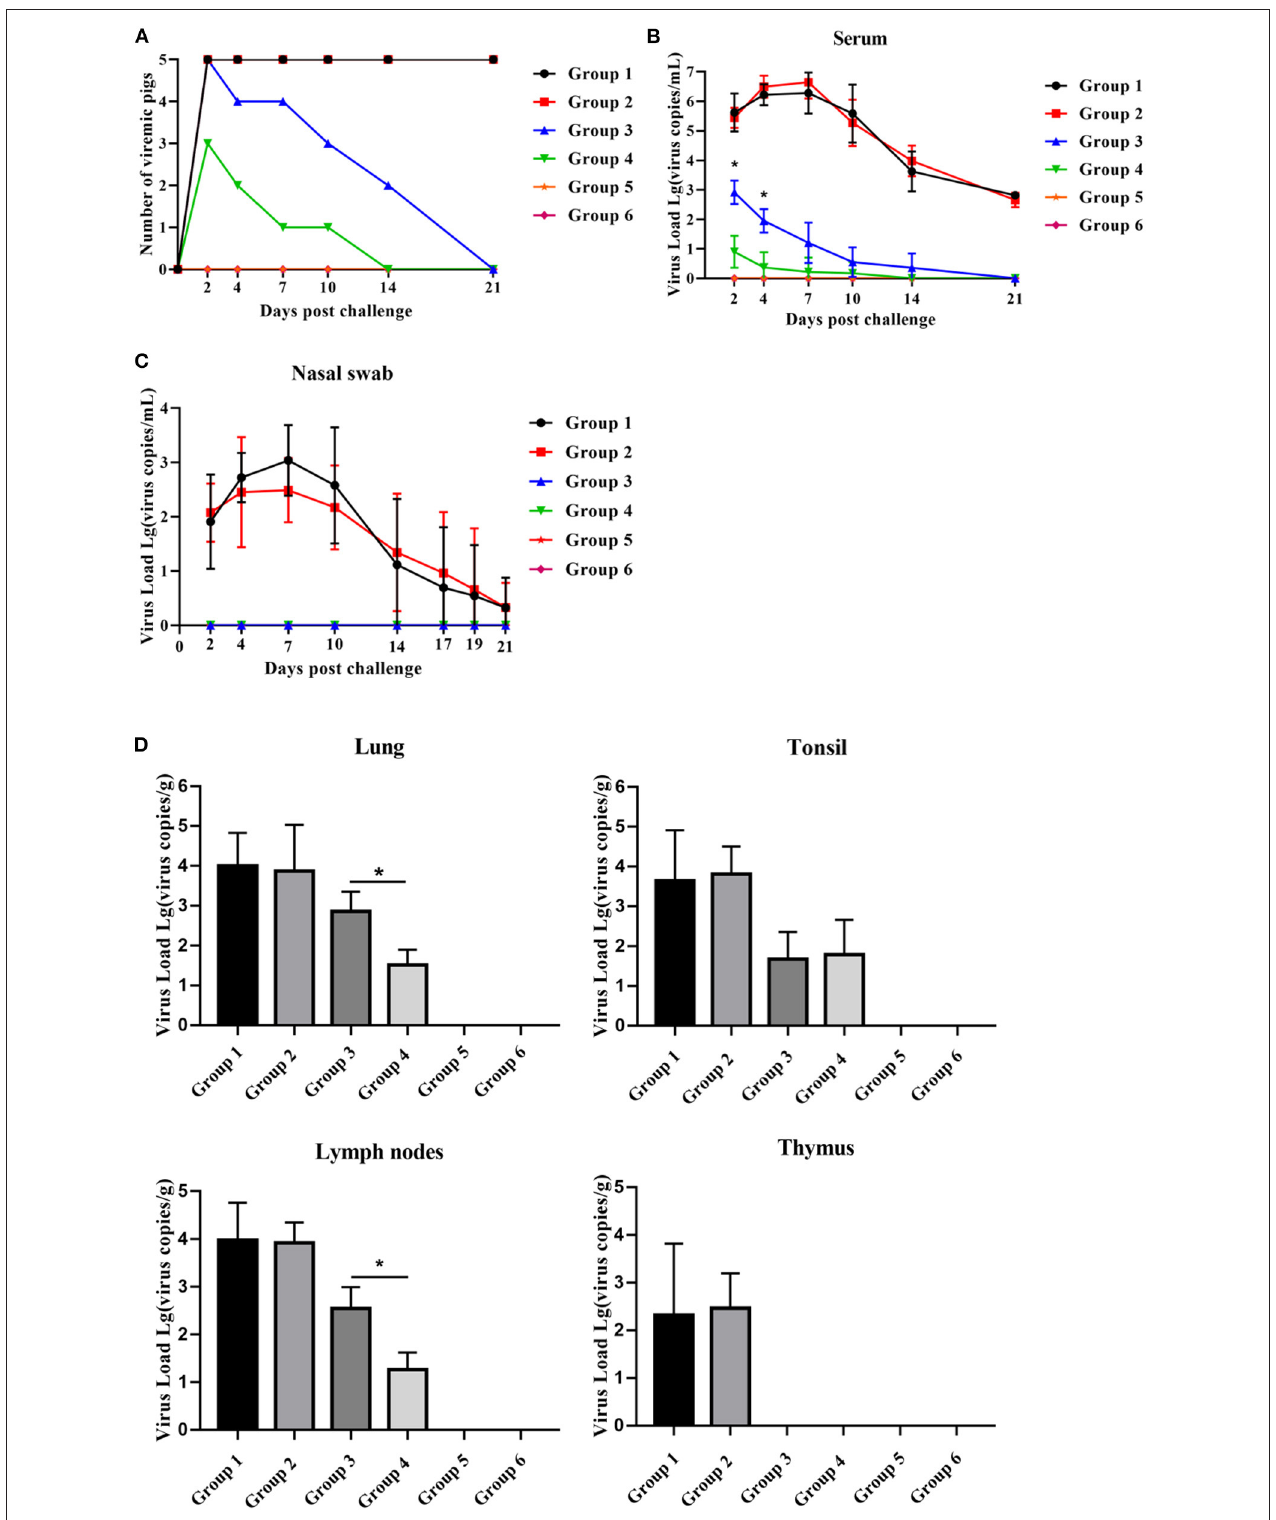
FIGURE 6 | PNS treatment significantly reduced HP-PRRSV viremia and tissue viral load. (A) The number of viremic pigs. (B) The level of PRRSV mRNA in serum, detected using qRT-PCR. The expression levels of PRRSV mRNA in nasal swabs (C) lungs, lymph nodse, tonsils, and thymus (D) , detected using qRT-PCR. Statistical significance is denoted by * p <